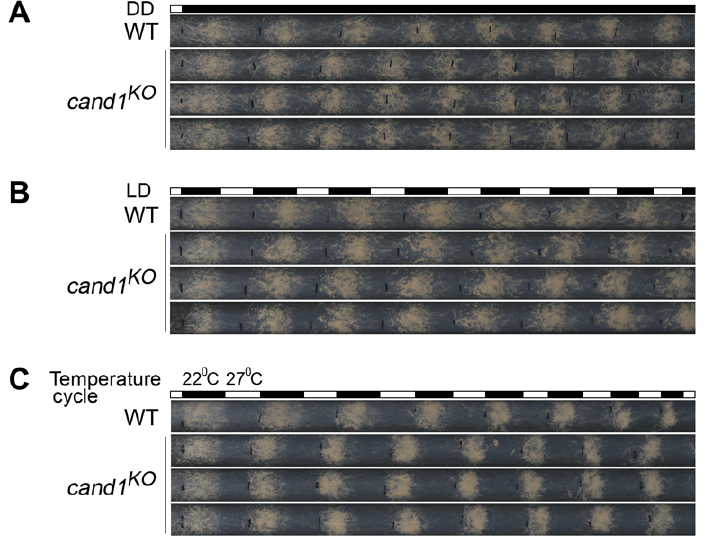
Figure 7. CAND1 is not required for regulation of the circadian rhythm. (A–C) Normal conidiation rhythms of cand1 mutants in dark–dark (A), light–dark (B), and temperature cycles (C) measured by race tube assays. At least four replicates were tested under each condition. Black lines